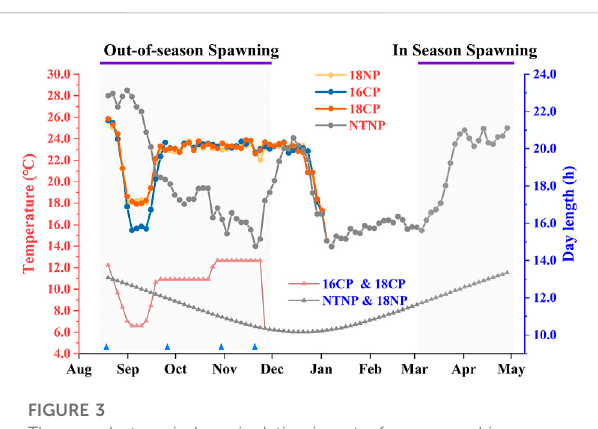
FIGURE 3 Thermo-photoperiod manipulation in out-of-season and in- seasonspawningoflargemouthbass.Theexperimentwasdividedinto four groups, i.e., 18NP (18 ° C overwintering water temperature, natural photoperiod), 18CP (18 ° C overwintering water temperature, controlled photoperiod), 16CP (16 ° C overwintering water temperature, controlled photoperiod), and NTNP (natural water temperature and natural photoperiod). The average water temperature and photoperiod every 3 days are indicated by the upper and lower lines, respectively. Blue triangles indicate the four sample points at Stage 1, Stage 2, Stage 3, and Stage 4, which are described in the 2.4 Sampling and histological and energy analysis section.